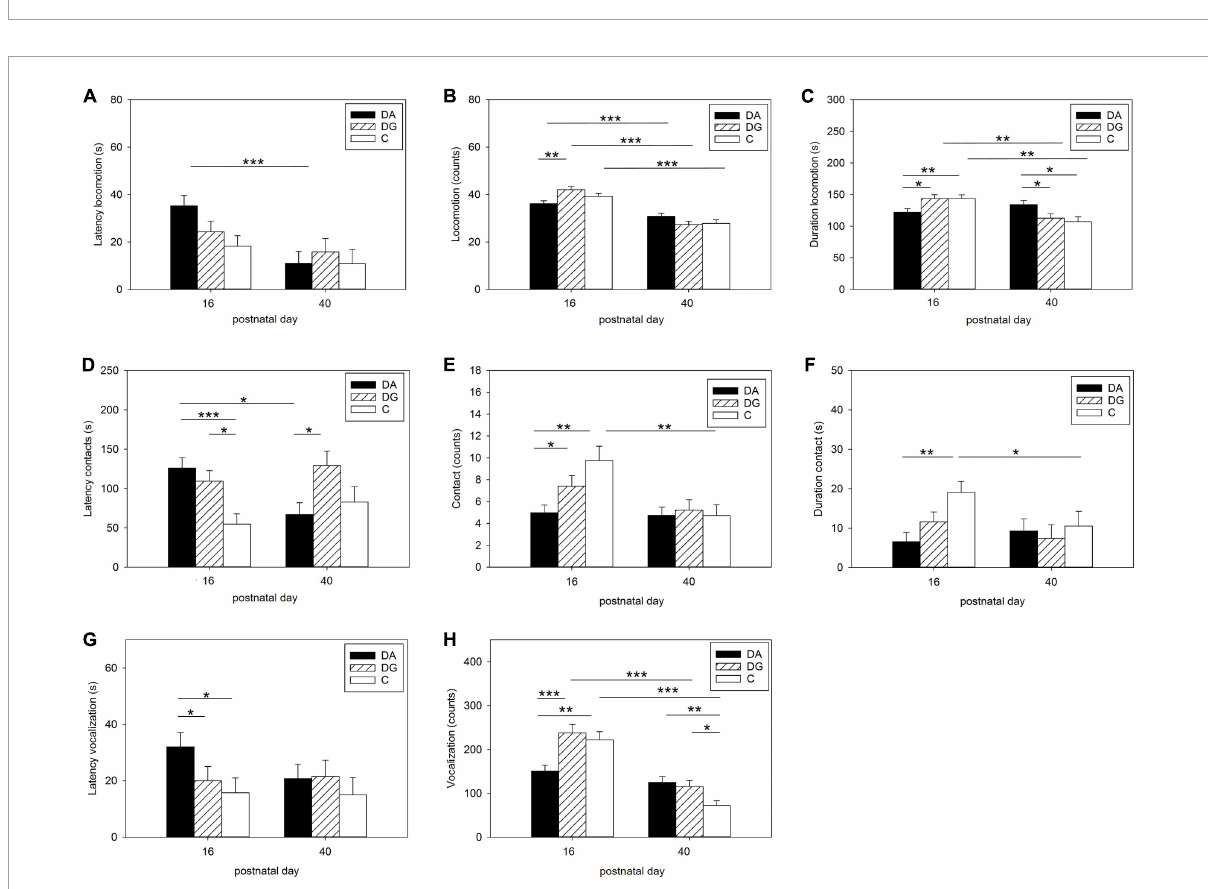
FIGURE3 Behavior in the open-field/novel-object test. Latency (A) , number (B) , and duration (C) of locomotion; Latency (D) , number (E) , and duration (F) of contact to the novel object; latency (G) , and number (H) of vocalizations during OF/NO test in the three treatment groups DA (deprivation alone), DG (deprivation in a group with littermates), and C (control, no deprivation). Results are presented as LSM ± SE. Significant differences (Tukey-Kramer test) are indicated with asterisks (* p < 0.05; ** p < 0.01; *** p < 0.001; PND 16: n = 52–55; PND 40: n = 24–33 per treatment